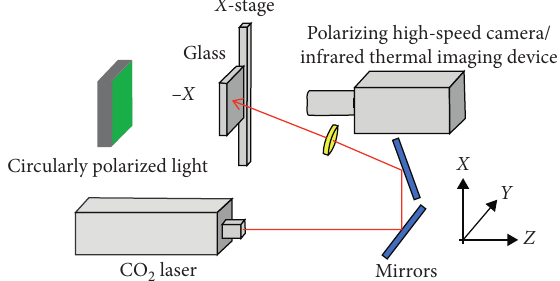
Figure 3: Schematic diagram of digital photoelasticity measure- ment principle